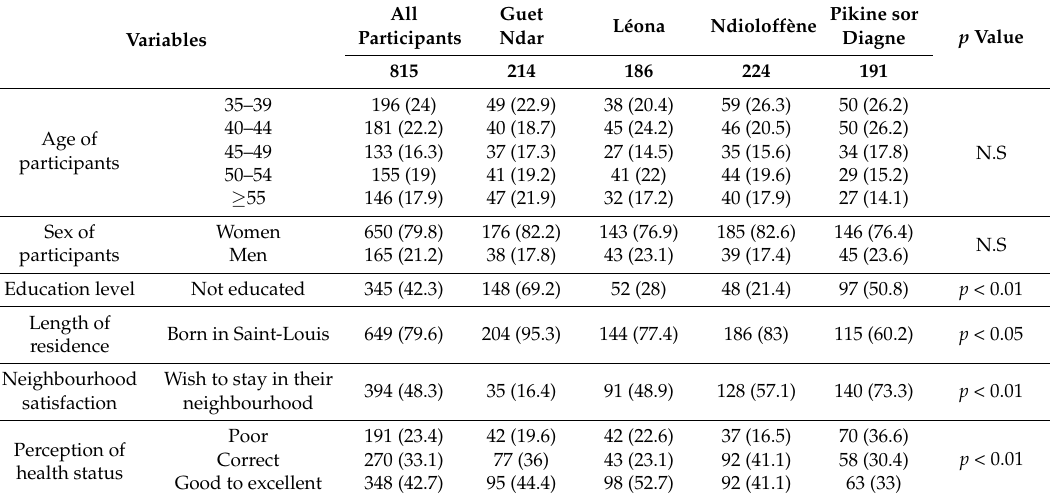
Table 1. Characteristics of the socio-medical survey